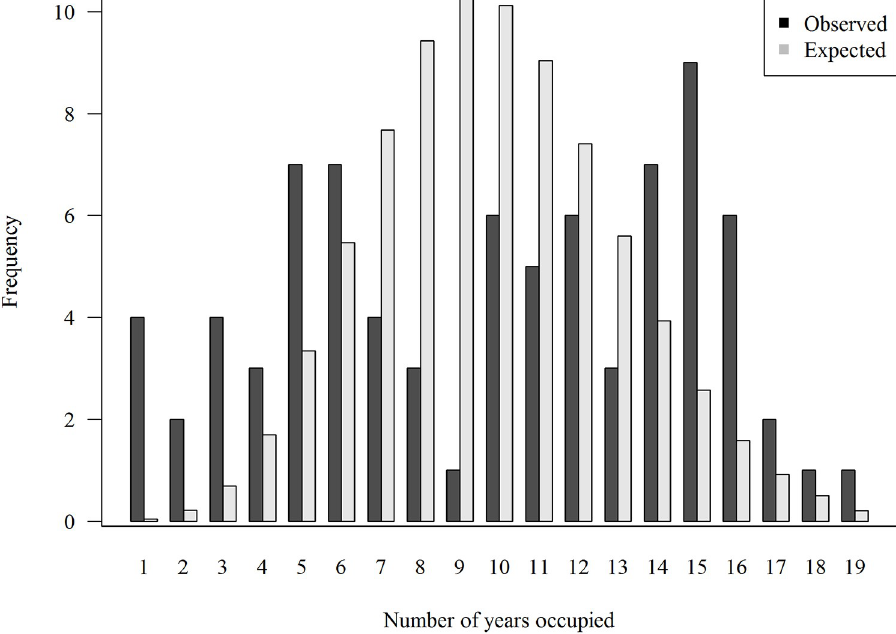
Fig 14. Breeding goshawks occupied territories non-randomly. Observed versus expected (from Poisson distribution) pattern of occupancy of 79 territories over 20 years by northern goshawks in Arizona, USA. https://doi.org/10.1371/journal.pone.0215841.g014 number of fledglings produced on each (range = 1 − 28 fledglings; � x ¼ 11 : 8 � 0 : 81 , median = 11.0, mode = 11.0) (Fig 15). The number of unique sequential breeders on the 79 territories ranged from 1–6 males ( � x ¼ 2 : 7 � 0 : 17 , median = 2) and 1–7 females ( � x ¼ 2 : 9 � 0 : 18 , median = 3) (Fig 16). Some of the most frequently occupied and most